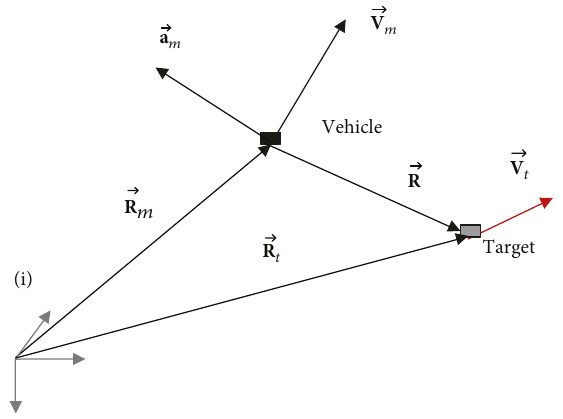
Figure 1: Three-dimensional vehicle/target